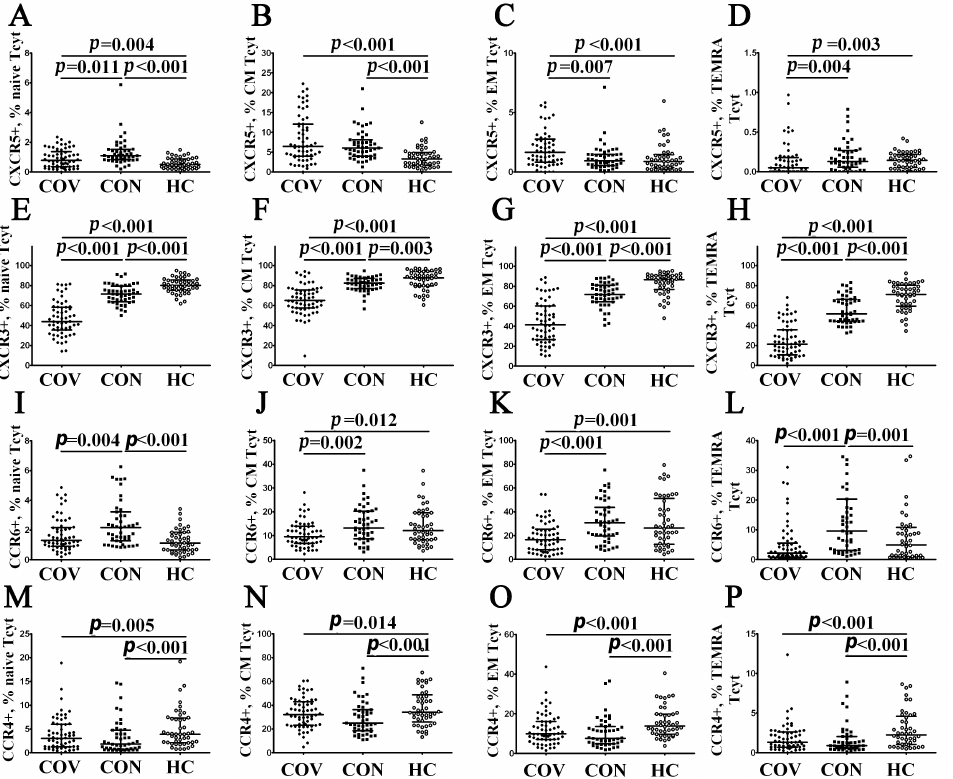
Figure 6. 6 Figure 6. Chemokine receptor profiles for major CD8+ T cell subsets with varying patterns of CD45RA and CD62L expression in acute and convalescent COVID-19 patients. Scatter plots ( A – D ), ( E – H ), ( I – L ) and ( M – P ) show the percentages of ‘naïve’ (CD45RA+CD62L+), central memory (CM, CD45RA − CD62L+), effector memory (EM, CD45RA − CD62L − ), and terminally differenti- ated CD45RA-positive effector memory (TEMRA, CD45RA+CD62L − ) CD8+ T cells, respectively, expressing CXCR5, CXCR3, CCR6, and CCR4, respectively. Black circles denote patients with acute COVID-19 (COV, n = 71); black squares—convalescent COVID-19 individuals (CON, n = 51); white circles—healthy control (HC, n = 46). Each dot represents individual subjects, and horizontal bars depict the group medians and quartile ranges (Med (Q25; Q75). In Figure 6, the statistical analysis was performed with the Mann–Whitney U